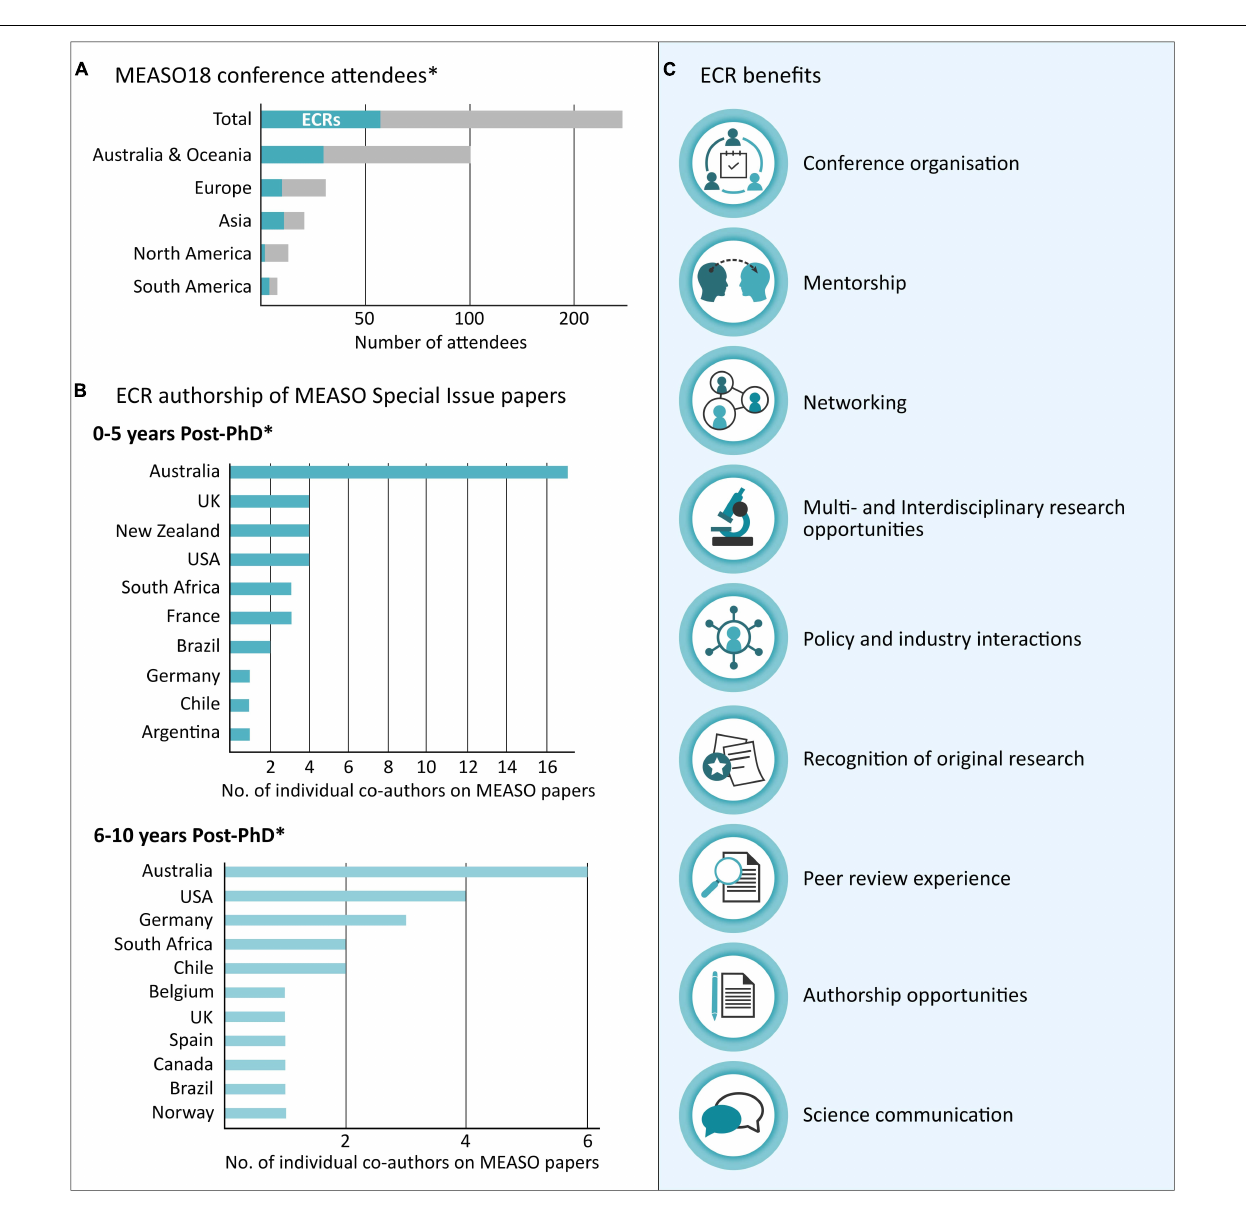
the Southern Ocean Knowledge and Information wiki (SOKI) 5